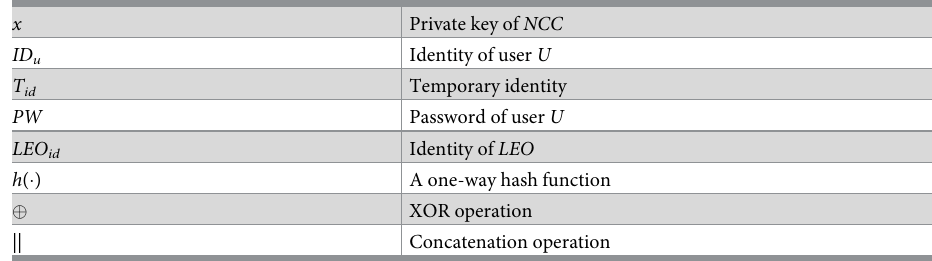
Table 1. Notions in this paper.